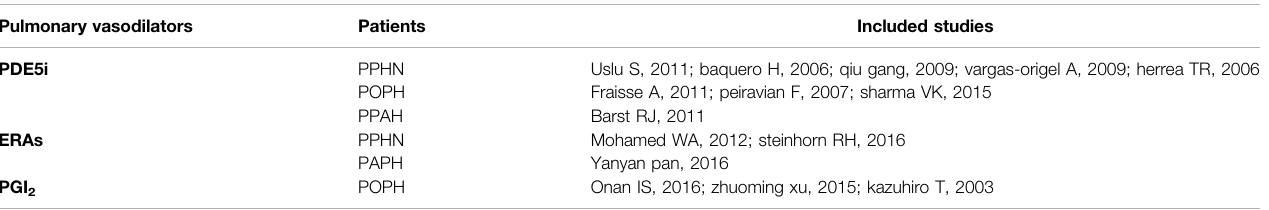
TABLE 2 | List of studies on pulmonary vasodilators for the treatment of different types of pediatric pulmonary hypertension. Pulmonary